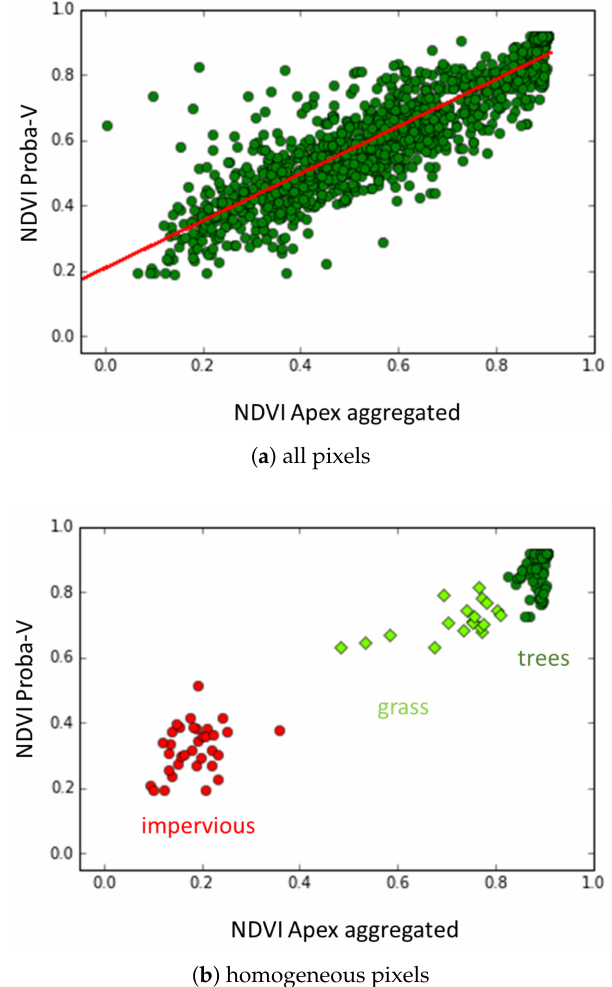
Figure 5. Proba-V vs. aggregated APEX NDVI values for the Watermaelbeek catchment for ( a ) all pixels and ( b ) homogeneous